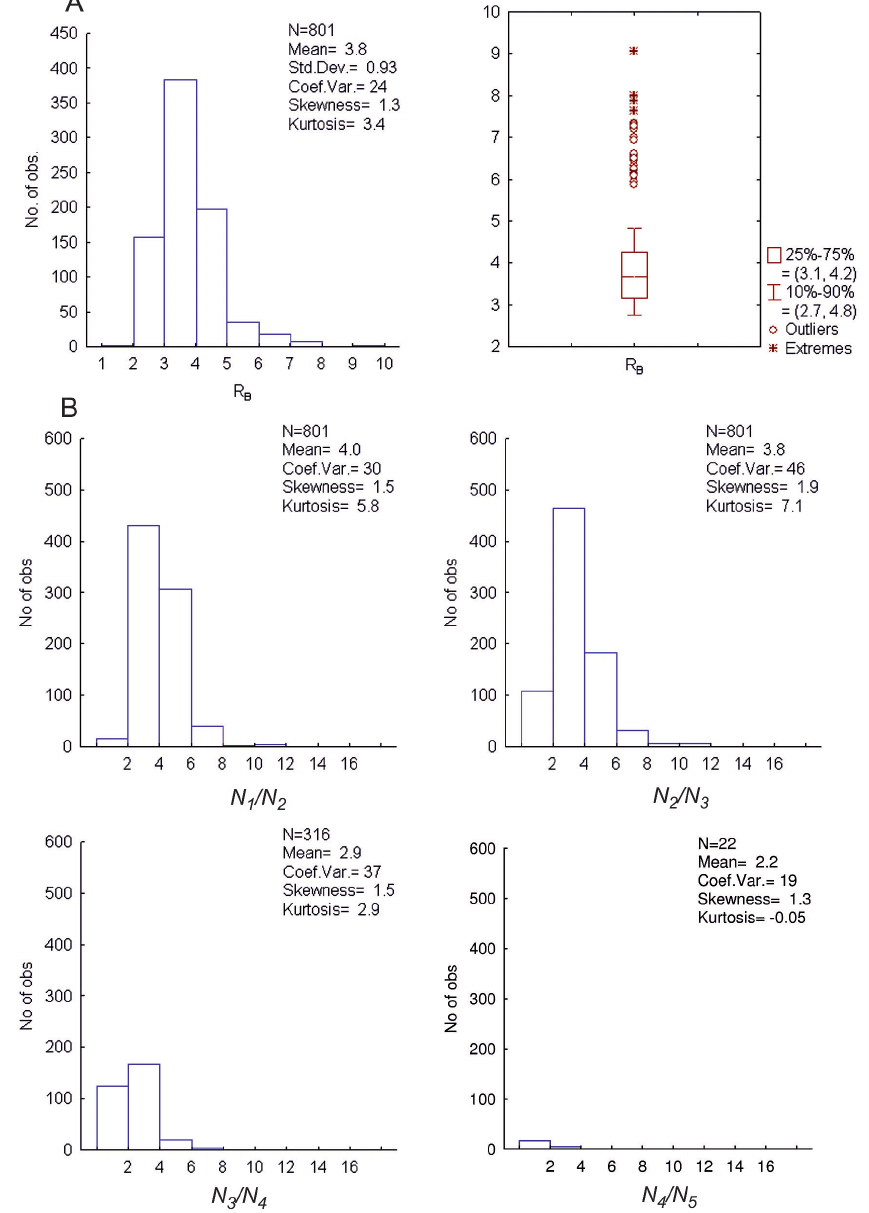
fig. 2. The bifurcation ratio (RB) in the investigated catchments – A, the growth rate of the bifurcation ratio – B. N – number of catchments, Coef.Var. – coefficient of